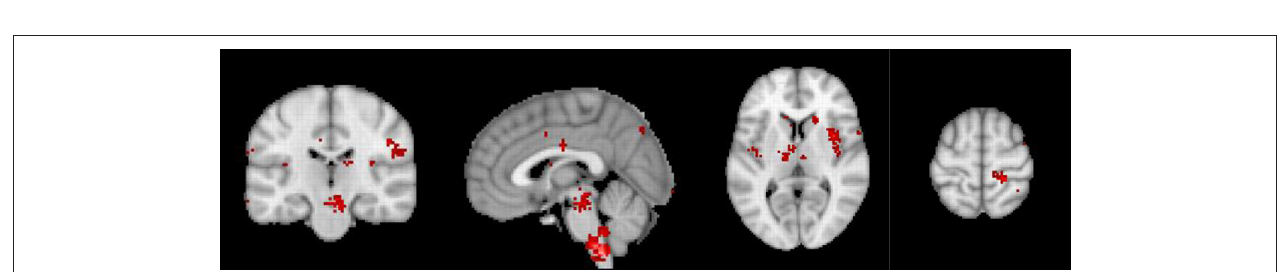
FIGURE 3 | Neurosynth meta-analysis of chronic pain. The pre to subgenual anterior cingulate component is absent, suggesting that chronic pain is related to lost inhibition. Modified from reference De Ridder et al. (29).